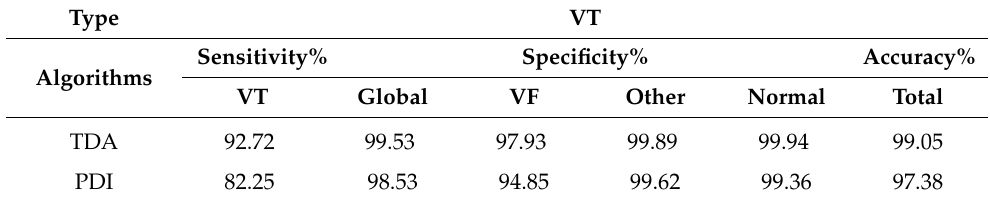
Table 7. Results obtained for VT class classification in